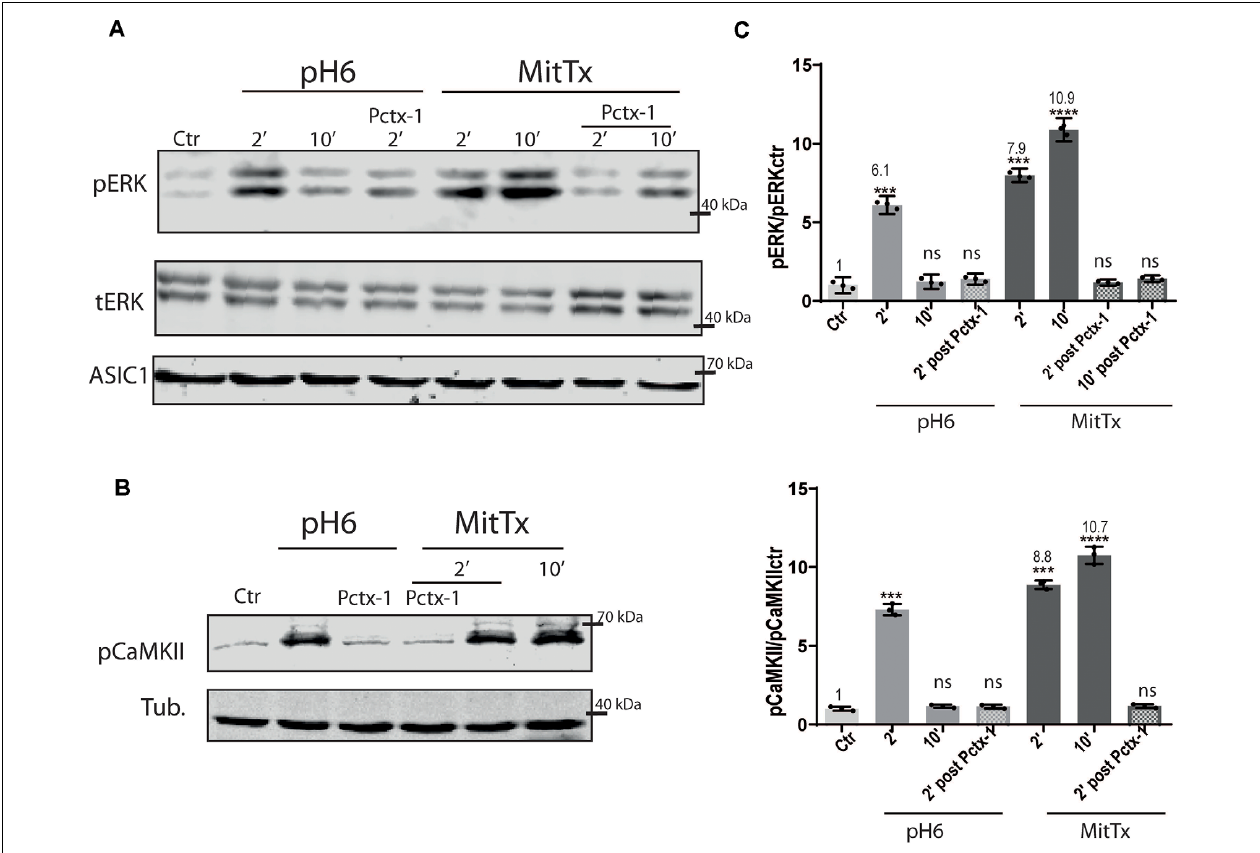
FIGURE 2 | Proton and non-proton activation of ASIC1a in HEK cells. (A) Representative membranes of lysates of HEK cells treated with pH6 or MitTx for 2 or 10 min or preincubated with Pctx-1 compared to untreated cells (control, Ctr) and detected with phosphoERK (pERK), total ERK (tERK), and ASIC1 antibodies. (B) Representative membrane of the same lysates to detect pCaMKII levels. (C) Plots showing detected levels of pERK (top panel) or pCaMKII (lower panel). Notice that the increase in kinase levels goes further at a later time point (2 vs. 10 min) in MitTx treated cultures compared to pH6 treated ones that show an increase at 2 min followed by a reversal to control levels consistent with the proton-activated desensitizing mechanism. (A) Notice that plots are the result of the signal intensity of the bands—with tERK and tubulin used as loading controls between loaded samples—and expressed relative to control samples. Data are presented as the mean ± SEM ANOVA and Dunnet post hoc test for treatments against the control were performed, mean values above bars; n = 3 membranes, **** p < 0.0001; *** p 0.0001–0.001; ns: no significant differences. Mean values expressed relative to control ( Ctr ) levels ± SEM are as follows: for pERK/tERK: pH6 2’ 6.10 ± 0.13; pH6 10’ 1.23 ± 0.11; pH6 2’ Pctx 1.39 ± 0.08; MitTx 2’ 7.98 ± 0.10; Mittx10 ’ 10.90 ± 0.17; MitTx 2’ Pctx 1.18 ± 0.05 ; MitTx 10’ Pctx 1.42 ± 0.05. For pCaMKII/Tub: pH6 2’ 7.31 ± 0.21; pH6 10’ 1.16 ± 0.06; pH6 2’ Pctx 1.14 ± 0.07; Mittx 2’ 8.88 ± 0.15; Mittx 10’ 10.76 ± 0.32; Mittx 2’ Pctx 1.17 ±